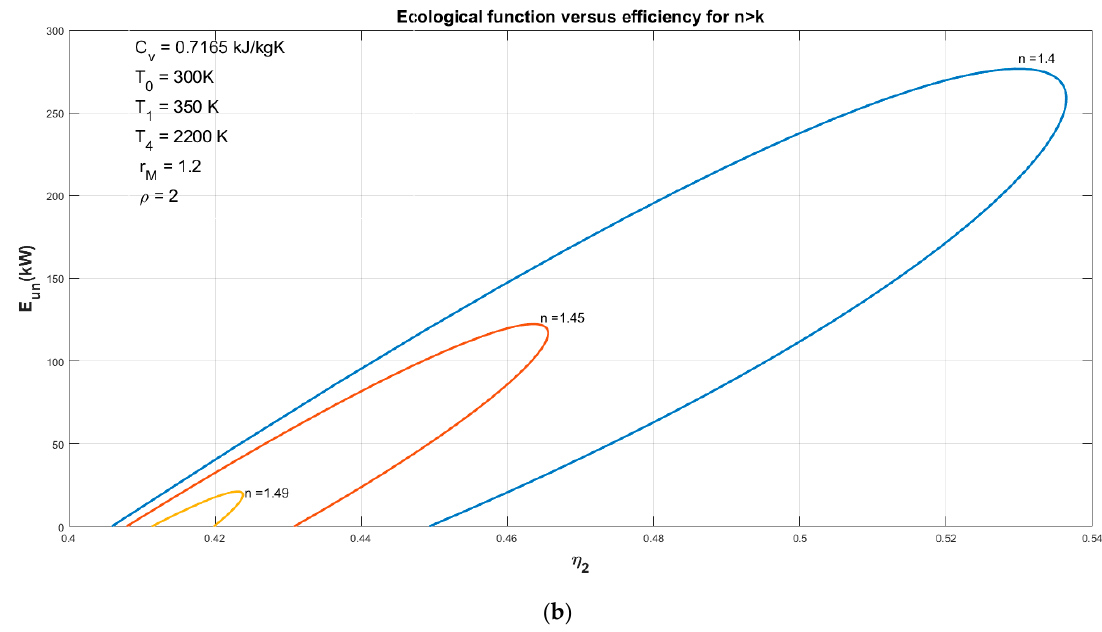
> k ) on E un – P 2 ( a ) and E un –